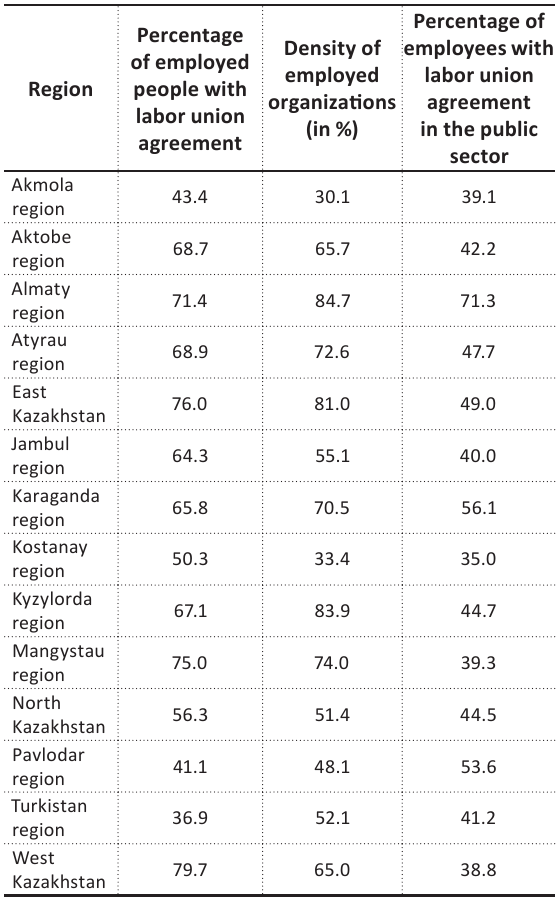
Table 1. Key indicators on labor unions and employees by